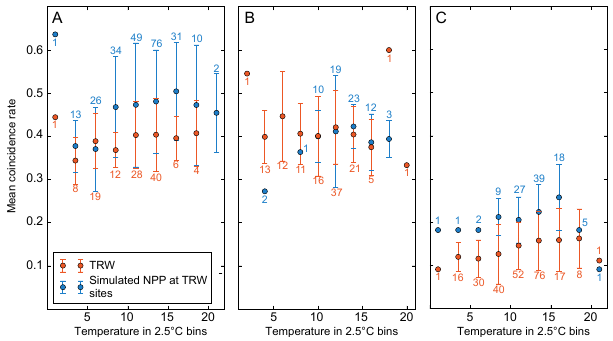
TRW Simulated NPP at TRW sites Temperature in 2. 5°C bins Figure 6. Significant coincidence rates of TRW (red dots) and sim- ulated NPP at TRW sites (blue dots) with (a) precipitation, (b) tem- perature, and (c) the combination of both, in climate space (as given in 2.5 ◦ C temperature bins, x axis) averaged over all tree species. Sites/ grid cells with significant coincidences are aggre- gated in 2.5 ◦ C mean annual temperature bins. Error bars give the standard deviation among sites/grid cells, and numbers in the plot denote the n of significant sites/grid cells for each 2.5 ◦ C tempera- ture bin (numbers for TRW in red and for simulated NPP in blue). Note that for some bins, for TRW or site NPP only one value